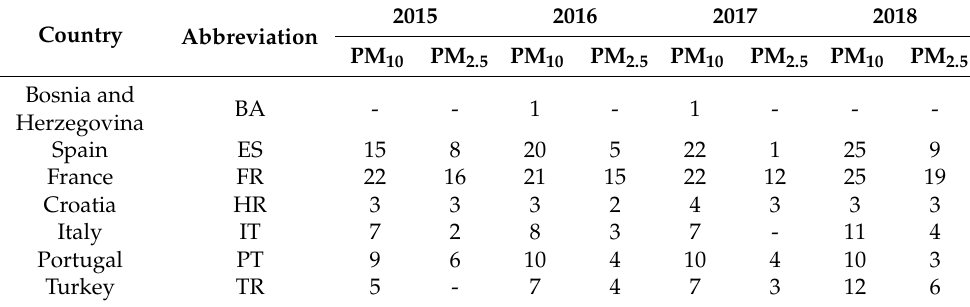
Table 1. Country distribution of PM 10 and PM 2.5 time series from background stations analysed in this study.